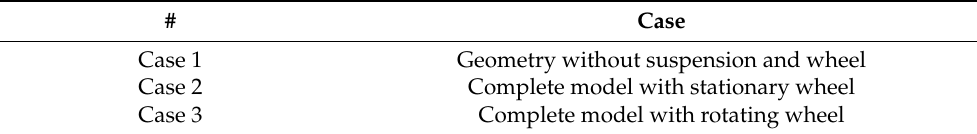
Table 1. Configurations simulated.